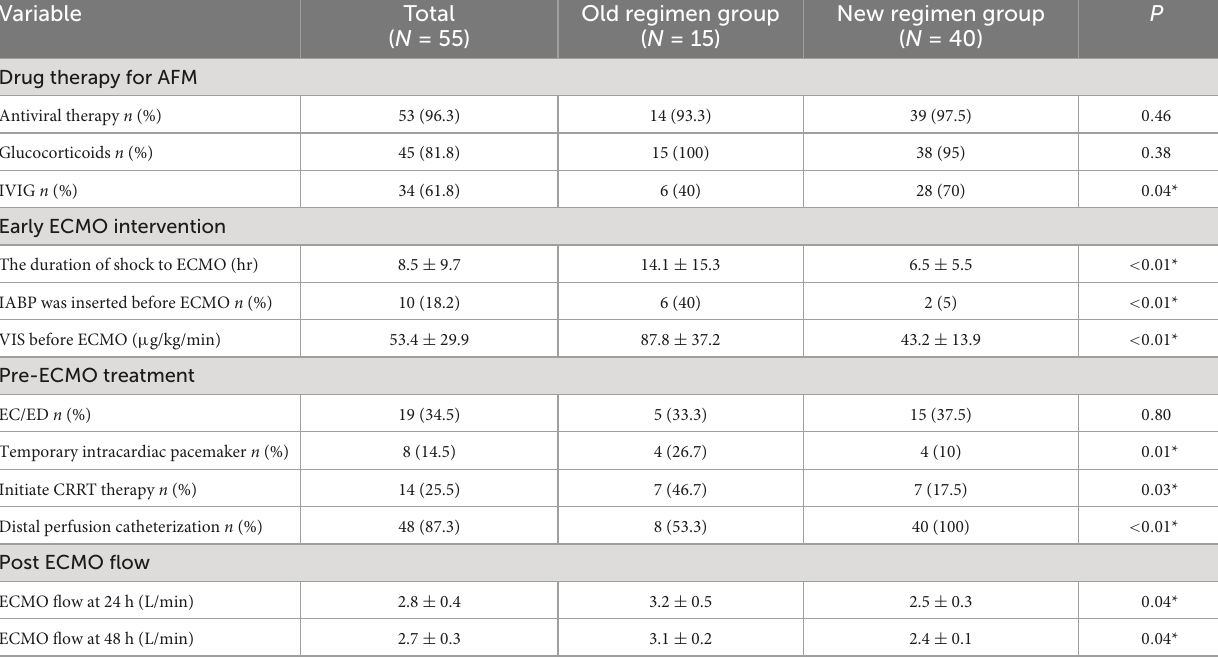
TABLE 2 Comparison of major interventions for AFM patients between the old and new regimen group. Variable Total